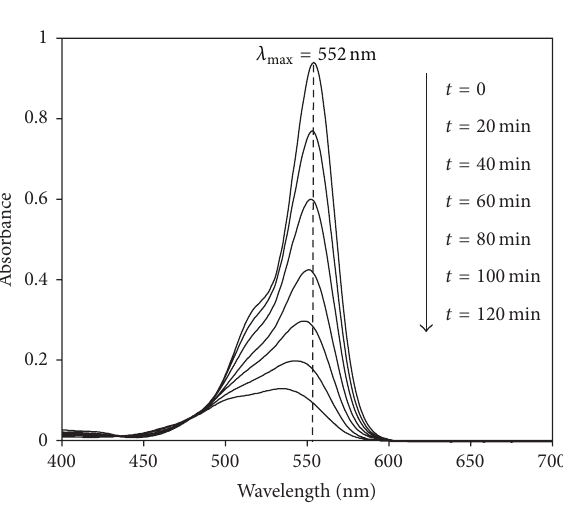
Figure 9: UV-Visible spectra of RhB upon photodegradation by BiVO 4